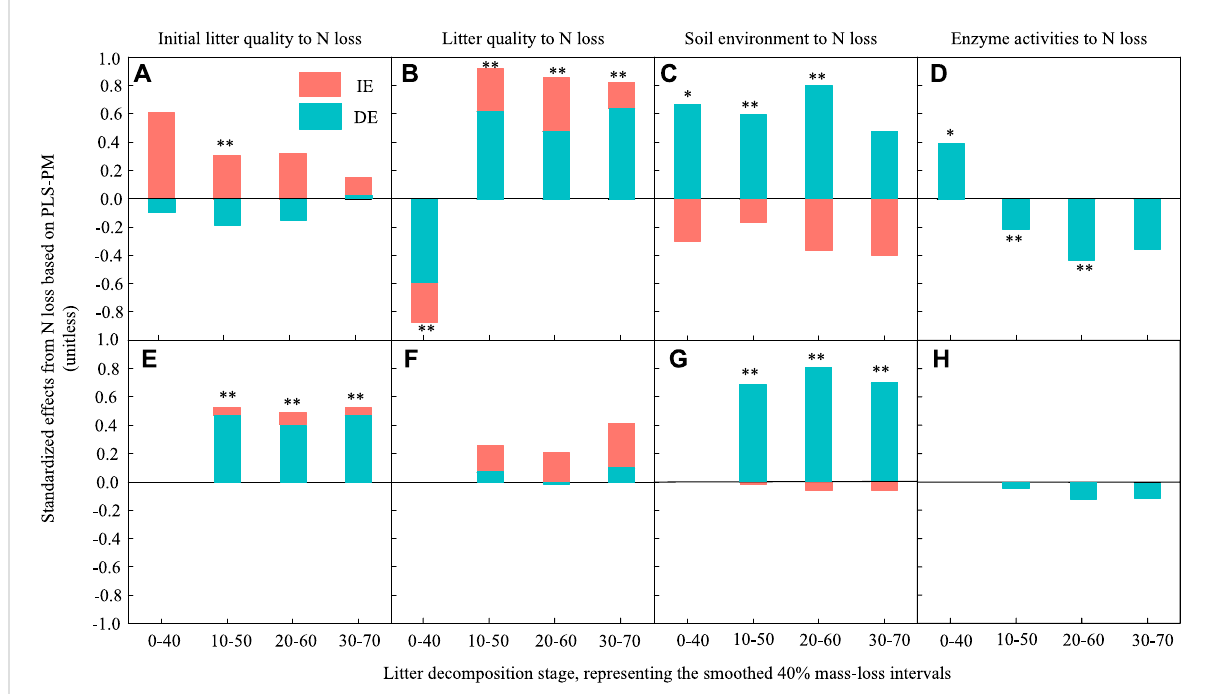
FIGURE 7 Standardizeddirectandindirecteffectsderivedfrompartialleastsquarespathmodelling(PLSPM)toassesstheeffectsofinitiallitterquality,litter quality,thesoilenvironmentandenzymeactivitiesonleafandrootlitterNlossesduringdecomposition. (A) and (E) representtheeffectofinitiallitter quality on N loss for leaf and rootlitters, respectively. (B) and (F) represent the effect of litter quality on Nlossfor leaf and root litters, respectively. (C) and (G) represent the effect of the soil environment on N loss for leaf and root litters, respectively. (D) and (H) represent the effect of enzyme activities on N loss for leaf and root litters, respectively. DE, standardized direct effect; IE, standardized indirect effect. ** p < 0.01, * p < 0.05.